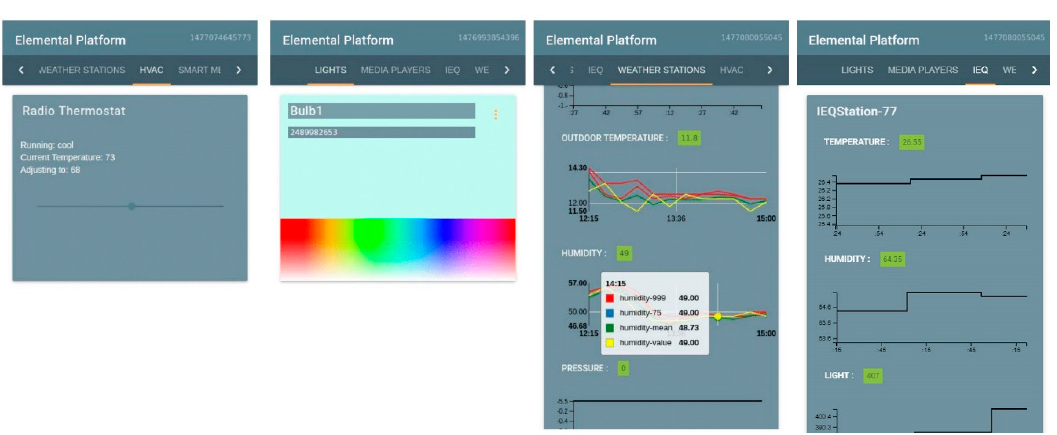
Figure 6. Various screens of the Elemental local dashboard running on a Raspberry Pi.